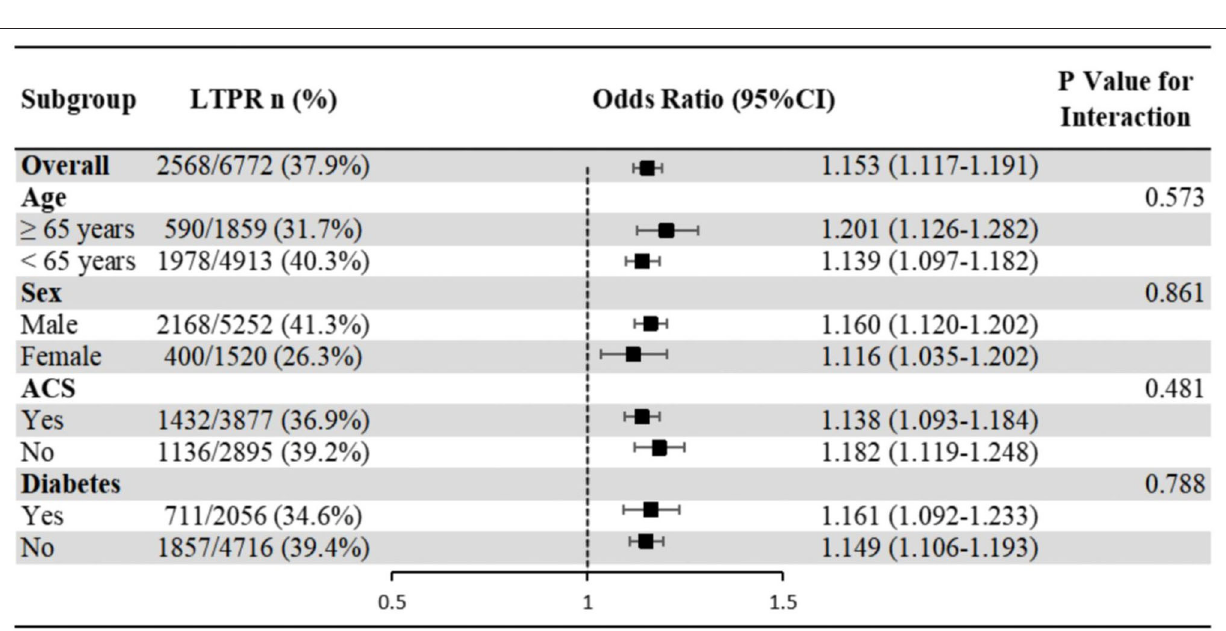
bleeding risk and no relevant mechanisms reported. Against